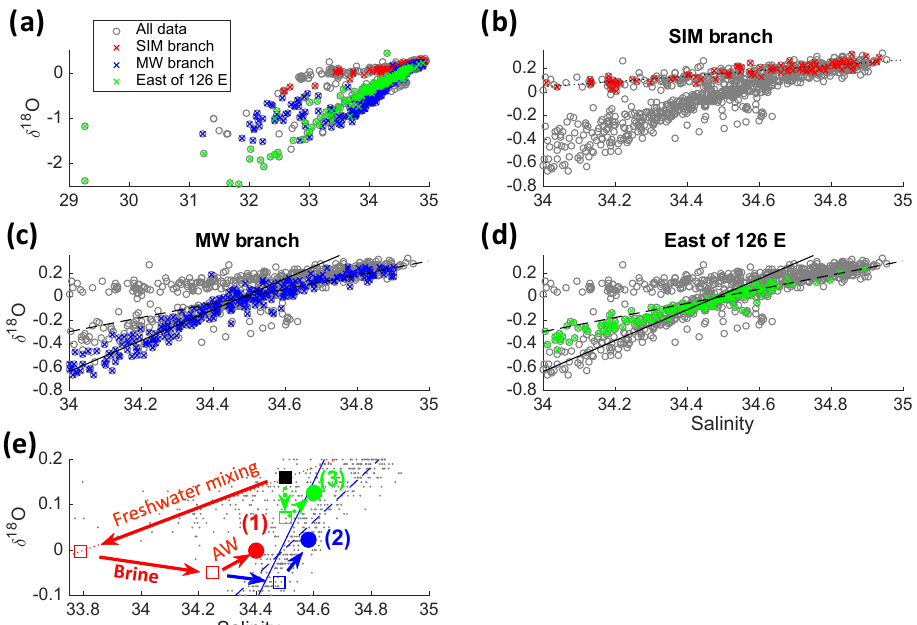
Figure 5. Plots of salinity versus the stable oxygen isotopic ratio ( δ 18 O) measured during the 2013 cruise. The entire data set is plotted in each panel as gray circles. Data collected from stations comprising the sea-ice meltwater (SIM) branch, meteoric water (MW) branch, and remaining stations located east of the L5 transect (L5.5 and L6 transects) are plotted as red, blue, and green X marks in panels (b) , (c) , and (d) , respectively. Linear regressions characterizing the SIM ( δ 18 O = 0.2287 × S − 7 . 7306; R 2 = 0.44) and MW ( δ 18 O = 0.6016 × S − 20 . 7517; R 2 = 0 . 69) branches ( S ≥ 34.5) are plotted as dotted and dashed lines, respectively. The lower MW branch (34 ≤ S <34.5) is plotted as a solid line ( δ 18 O = 1.3126 × S − 45.2639; R 2 = 0.89). Both MW branches are plotted in panel (d) for comparison against data along L5.5 and L6 transects. Note that the inclusion of all data collected east of 126 ◦ E results in a linear regression that was statistically indistinguishable from the MW branch ( δ 18 O = 0.63 S − 21.8; R 2 = 0.71); however, this was not the case for the lower salinity range; thus, these stations were excluded in the definition of the MW branches. Panel (e) illustrates the transition from the SIM branch to the MW branch via mixing with overlying freshwater, salinization through sea-ice formation/brine release, and mixing with AW. The red pathway illustrates the effect of vertical mixing down to ∼ 50m (the mean winter mixed-layer depth at SIM branch stations), brine expulsion due to the formation of 1m of sea ice, and mixing with AW in a 21 : 79 ratio to form lower halocline water with a salinity of 34.4 and δ 18 O of 0‰. The blue pathway deviates from the red pathway due to additional ice formation (1.5m instead of 1m) to form lower halocline water with a salinity of 34.58 and δ 18 O of 0.02‰. The green pathway illustrates the effect of vertical mixing to 100m, 1m of sea-ice formation, and AW mixing to form lower halocline water with a salinity of 34.6 and δ 18 O of 0.13‰. Empty squares indicate transition points after each step, whereas filled circles indicate the final halocline water product formed by the three potential pathways. All three pathways yield salinity and δ 18 O combinations near (but not directly on) the MW mixing branches, indicating some additional processes and/or mixing (such as freshwater influence from river runoff) take place during the transition from the SIM branch to the MW branch. A larger version of this figure is available in the Supplement, Fig.